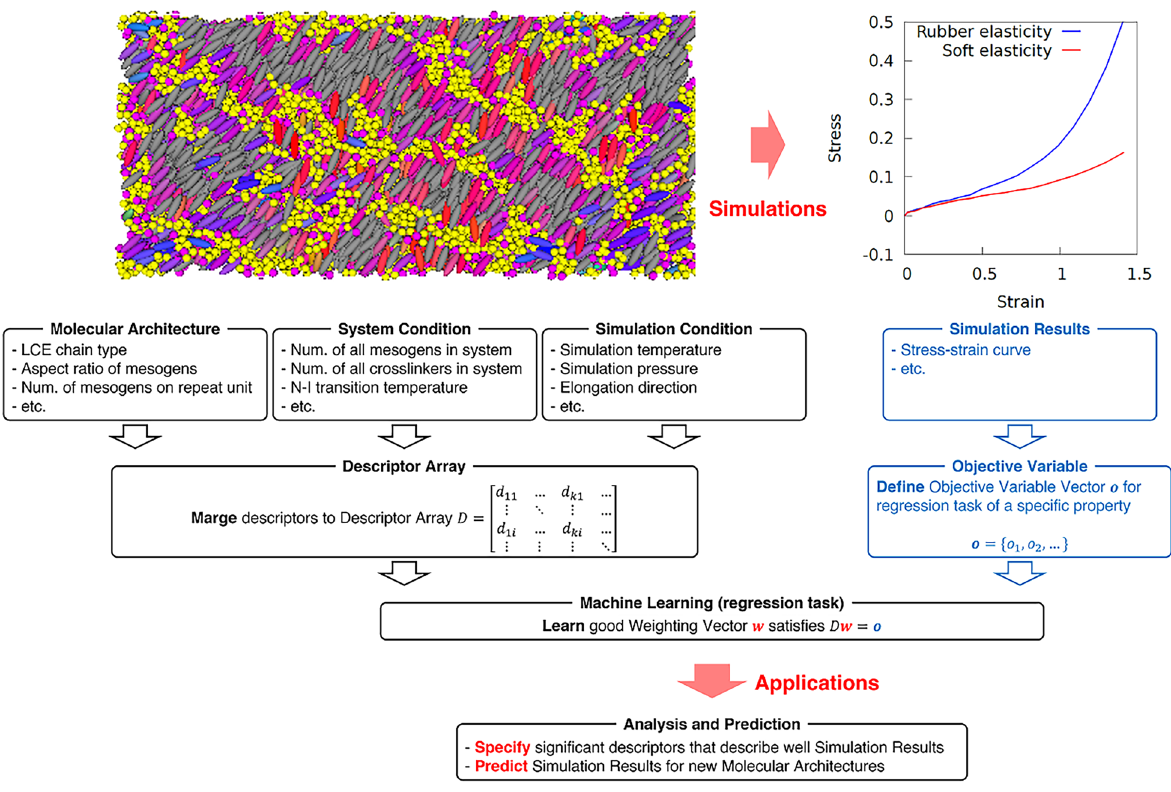
Figure 2. ML flow in this